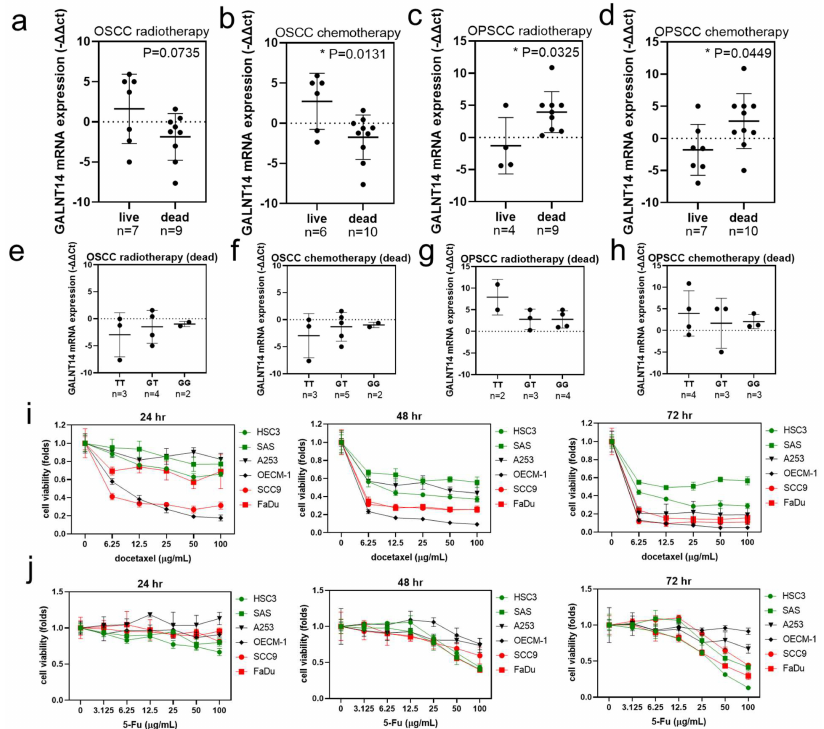
Figure 5. Relationship between GALNT14 mRNA expression level, GALNT14 -rs9679162 genotypes and radiotherapy, chemotherapy survival status in OSCC and OPSCC. GALNT14 mRNA expression level (circle, − ∆∆ Ct of each paired tissue; black lines, mean ± SD) with respect to radiotherapy survival status in ( a ) OSCC and ( c ) OPSCC, and chemotherapy survival status in ( b ) OSCC and ( d ) OPSCC. GALNT14 mRNA expression level (circle, − ∆∆ Ct of each paired tissue; black lines, mean ± SD) in the GALNT14 -rs9679162 genotypes in the dead radiotherapy recipients in ( e ) OSCC and ( g ) OPSCC, and in the dead chemotherapy recipients in ( f ) OSCC and ( h ) OPSCC. ( i ) The chemoresistance ability of six OSCC cell lines after treatment with vehicle or 6.25–100 µ g/mL docetaxel for 24, 48, and 72 h. ( j ) The chemoresistance ability of 6 OSCC cell lines after treatment with vehicle or 3.125–100 µ g/mL 5-Fu for 24, 48, and 72 h. One-way ANOVA was used to analyze the data in ( b – h ). * p <